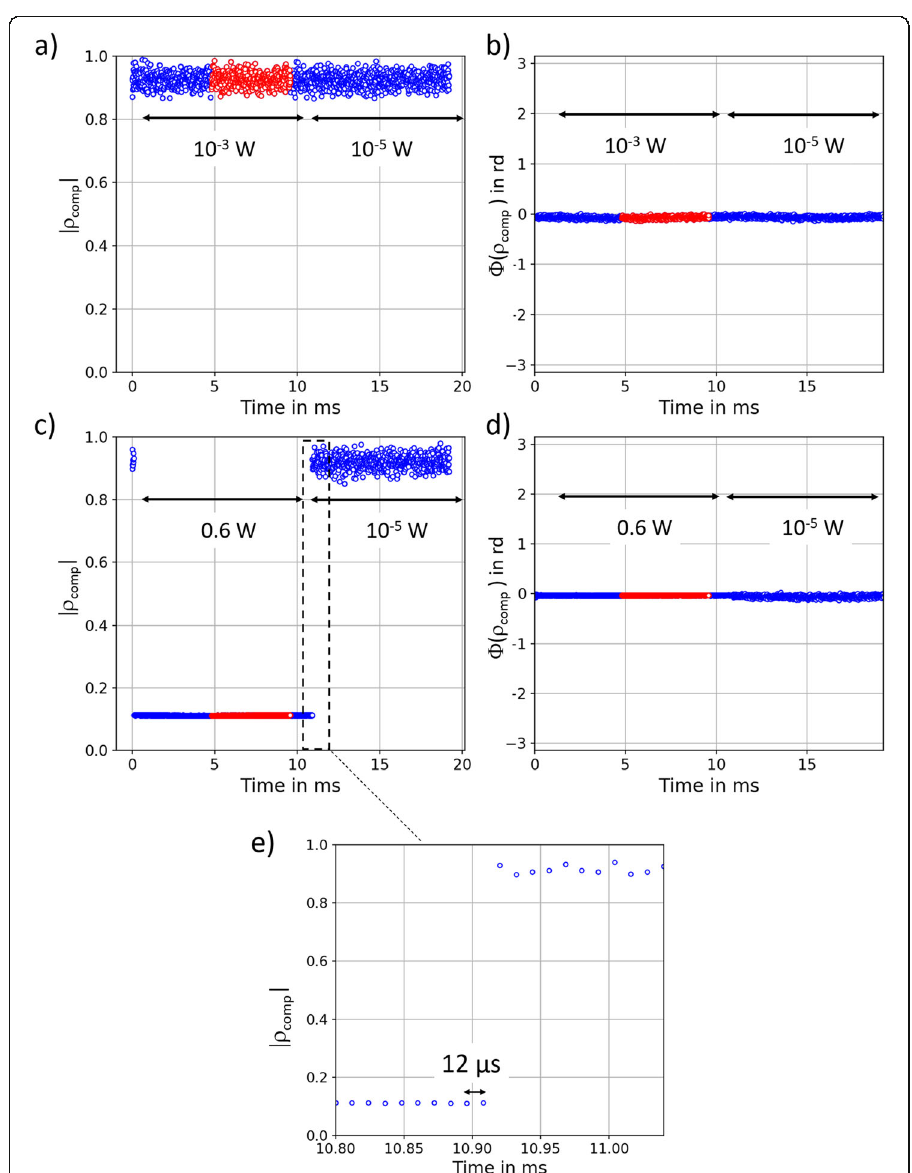
applied and pulse duration: In the presented results, the incident power is 10 − 3 W ( a and b ) or 0.6 W ( c and d ) to simulate RF transmission in the first stage, then 10 − 5 W to simulate RF reception. ( a ) and ( c ) show the magnitude values of ρ comp for 10 − 3 W and 0.6 W, respectively. ( b ) and ( d ) represent the phase values of ρ comp for 10 − 3 W and 0.6 W, respectively. ( e ) shows the transition time between two different power